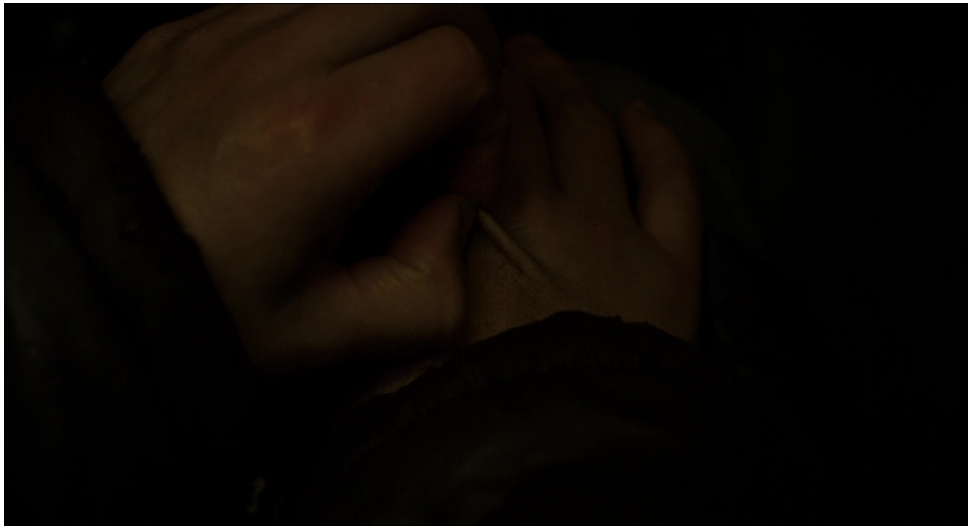
Figure 6: Adam Pearson in Under the Skin directed by Jonathan Glazer. 2013; London: BFI & Film 4.